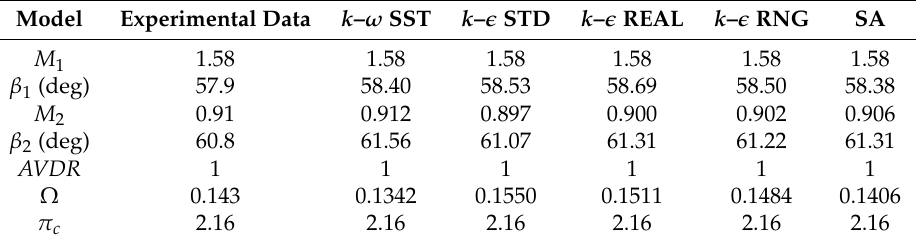
Table 5. Global quantities in the experimental test and calculated with different turbulence models. Model Experimental Data